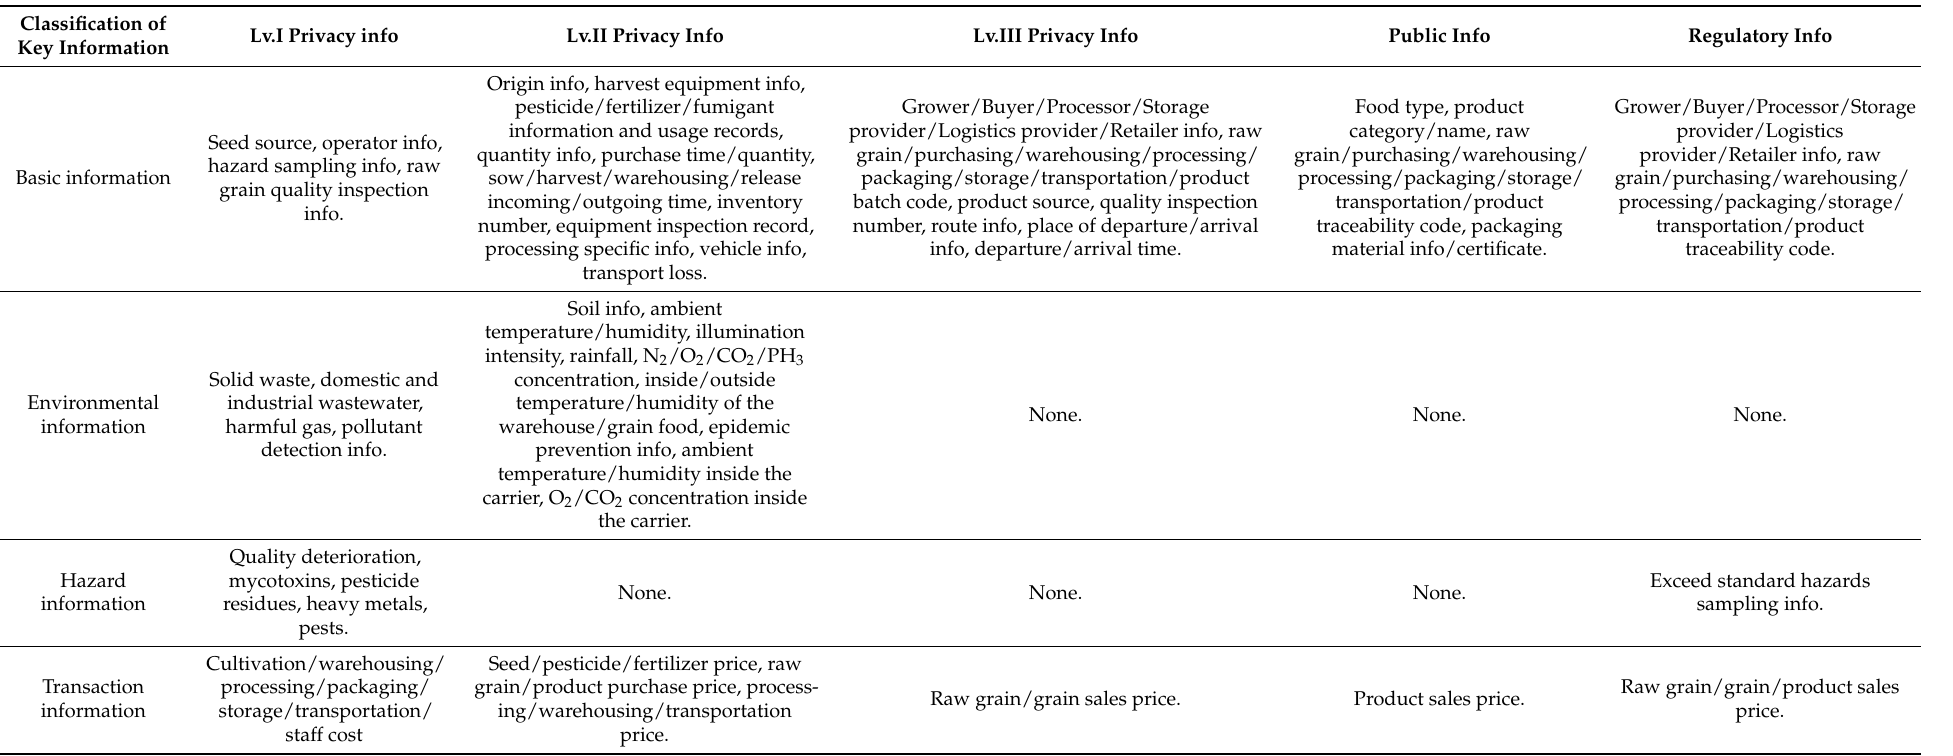
Table 2. Grading of privacy authority for key information in the grain food supply